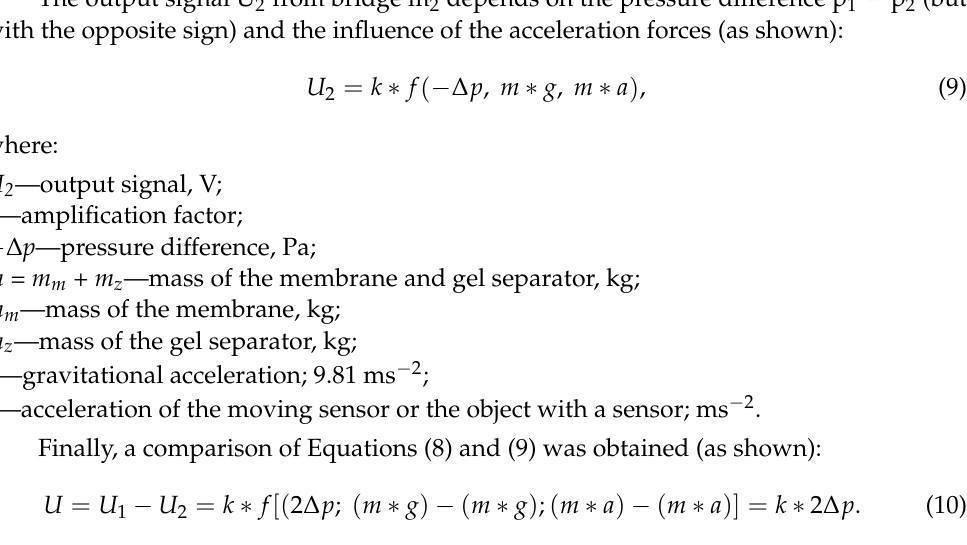
occurrence of forces from